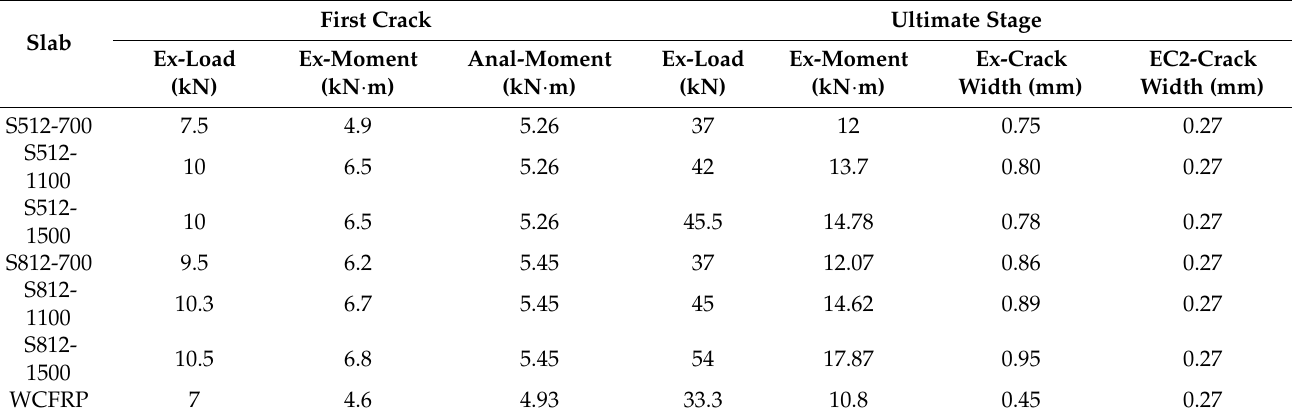
Table 8. Experimental versus analytical results for estimating first crack moment and crack width.